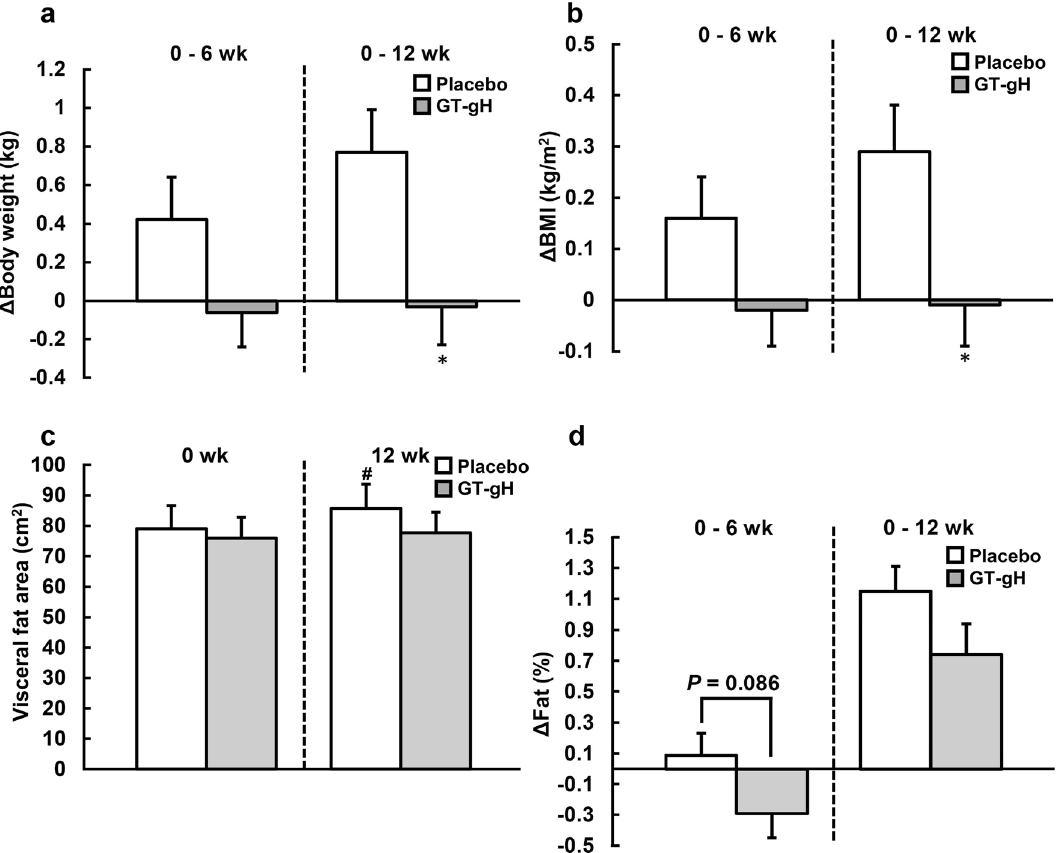
Figure 2. Diachronic change in visceral fat area, body weight, BMI and fat in the placebo (n = 27) and GT-gH (n = 29) groups. ( a ) Body weight, ( b ) BMI and ( d ) fat were measured by a dual-frequency body composition analyzer, and the changes in their values were analyzed by an independent two-sample t -test. ( c ) The visceral fat area was measured by PET-CT and Fat Checker. For between-group comparisons, the values were analyzed using an independent two-sample t -test. * P < 0.05 (vs. placebo). For within-group comparisons, the values were analysed by a paired t -test. # P < 0.05 (vs. week 0). Grey bars represent GT-gH, and open bars represent placebo. Data are shown as means ± SE. BMI, body mass index; GT-gH, green tea with α-glucosyl hesperidin; PET-CT, positron emission tomography with computed